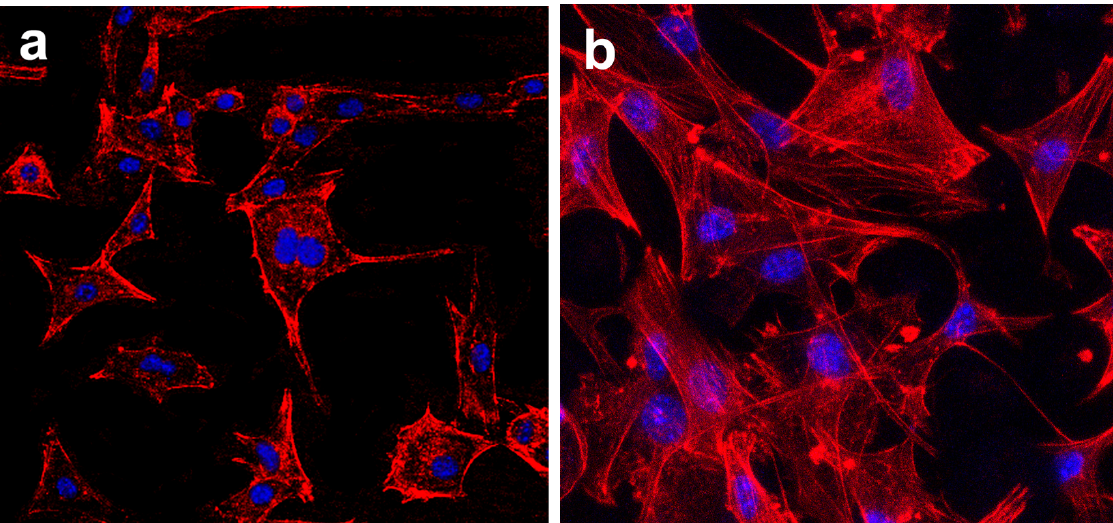
Figure 9. CLSM (red (cytoskeleton) and blue (nuclei)) of MC3T3s cell on ( a ) MBG-CP-Ti and ( b ) MBG-SLM-Ti after 3 days.